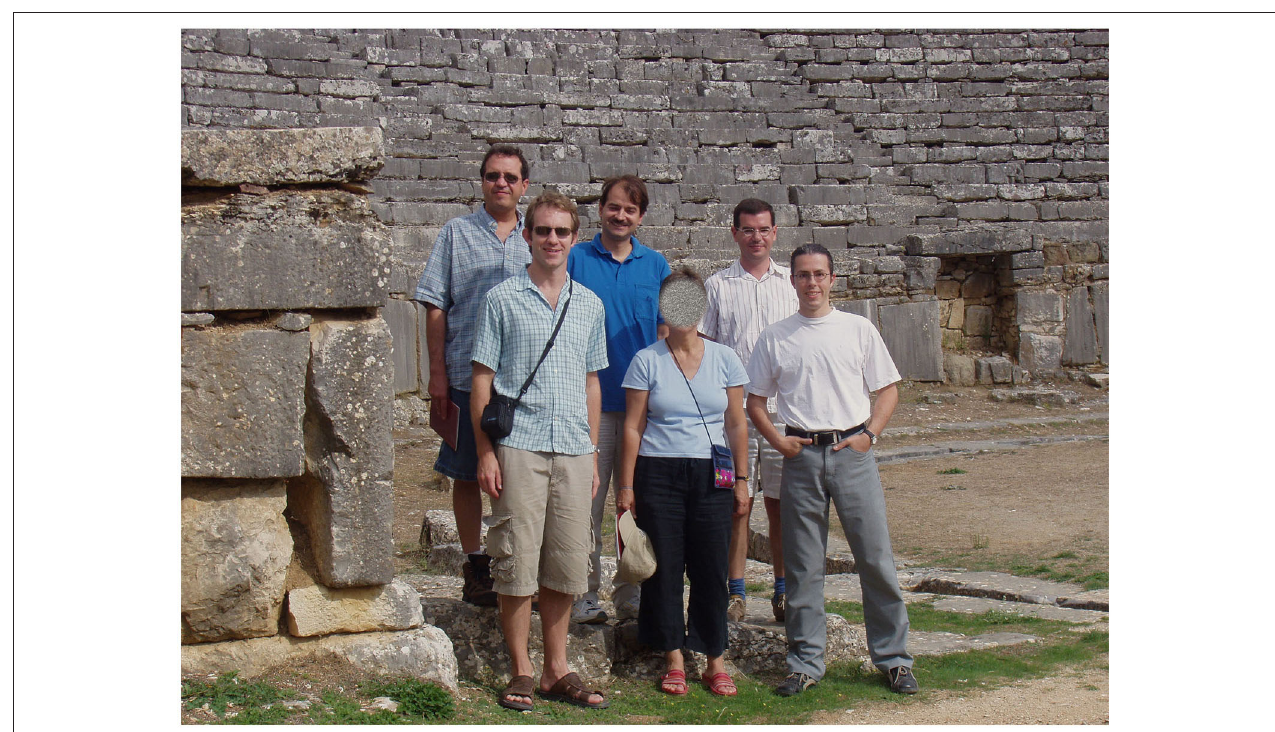
FIGURE 1 | Founding members of GEoPD in Greece in 2004. Permission for publishing this figure has been obtained from the five individuals